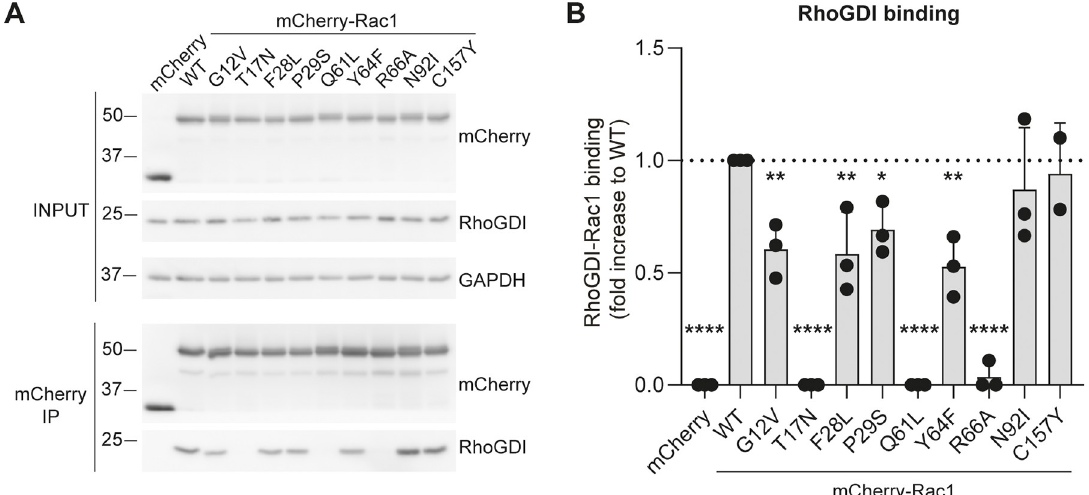
Fig 3. GDI binding properties of Rac1 activating mutants in cells. A and B) Representative Western blot (A) and quantification (B) of mCherry-Rac1 Co-IP with endogenous RhoGDI. MCherry-Rac1 was expressed in HEK293T cells, after which Co-IP for mCherry was performed as described in materials and methods. � p < 0.05, �� p < 0.01 and ���� p < 0.001 in compared to WT in Holm-Sidak’s post-hoc test of one-way ANOVA (n = 3).